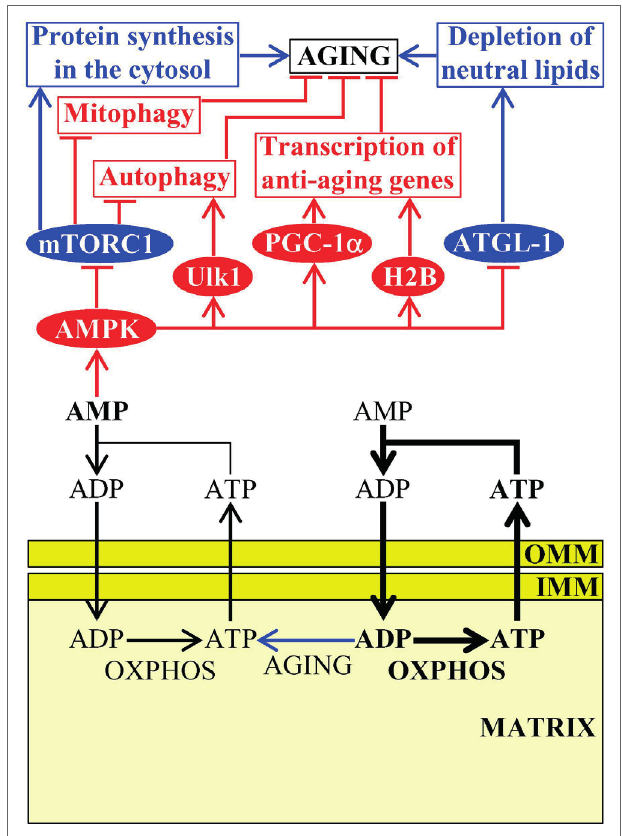
FIGURE 3 | Mitochondria-dependent modulation of AMP concentration in the cytosol is involved in aging. An aging-associated decline in mitochondrial functionality causes a rise in the concentration of AMP outside of mitochondria. AMP then activates AMPK, which phosphorylates and changes activities of several proteins that have a significant impact on aging by influencing several longevity-defining cellular processes. Activation arrows and inhibition bars denote pro-aging (displayed in blue color) or anti-aging processes (displayed in red color). Pro-aging or anti-aging proteins are displayed in blue or red color, respectively. See the text for additional details. Abbreviations: AMPK, AMP-activated protein kinase; ATGL-1, adipose triglyceride lipase 1; H2B, histone 2B; IMM, inner mitochondrial membrane; mTORC1, mammalian (or mechanistic) target of rapamycin complex 1; OMM, outer mitochondrial membrane; OXPHOS, oxidative phosphorylation; PGC-1 α , peroxisome proliferator-activated receptor gamma coactivator 1-alpha; ULK1, Unc-51 like autophagy activating kinase